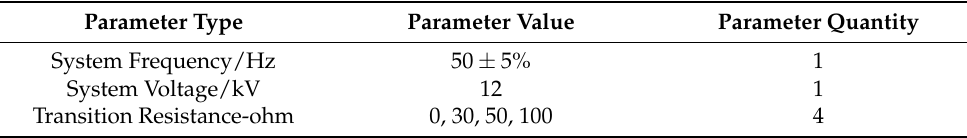
Table 2. Fault dataset